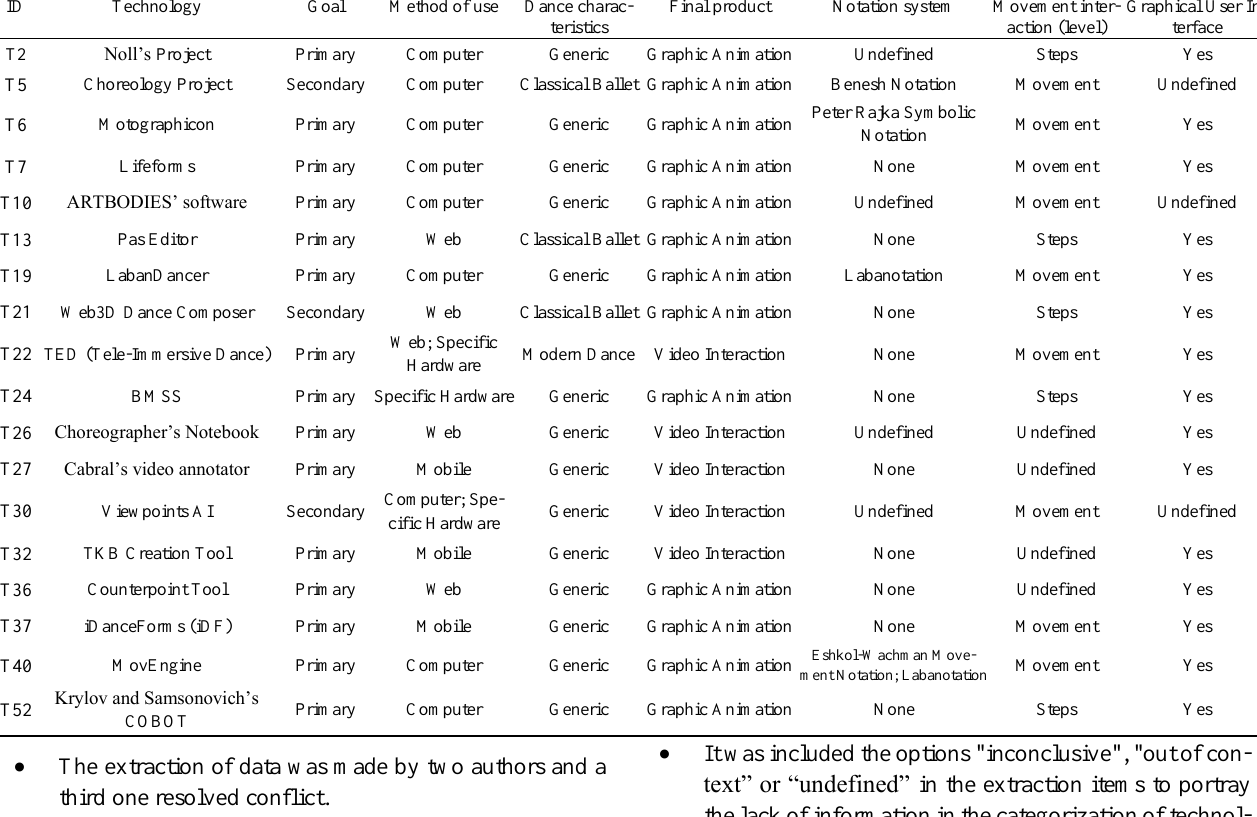
Figure 4. Timeline of the technologies considered in this research and classification in the filtering process. Source: The authors. Table 5. Modus operandi of the technologies selected. Source: The